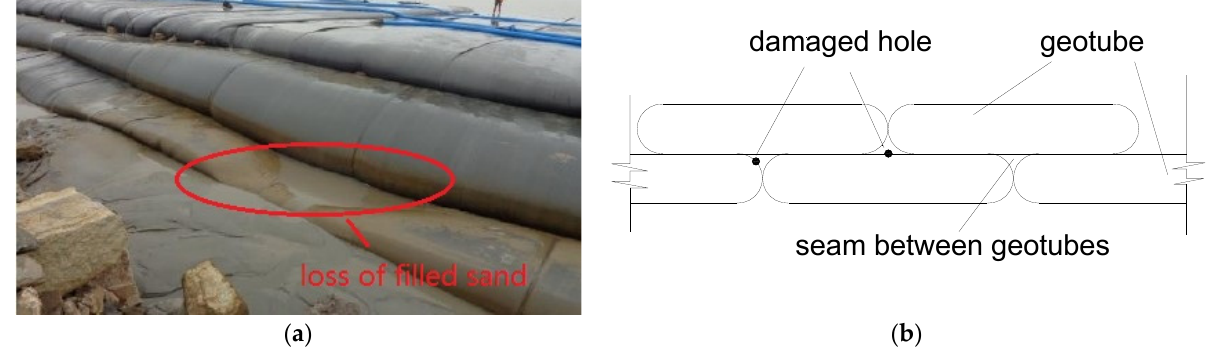
Figure 1. ( a ) field photo and ( b ) simplified diagram, geotextile tubes collapse and joint seams between tubes.